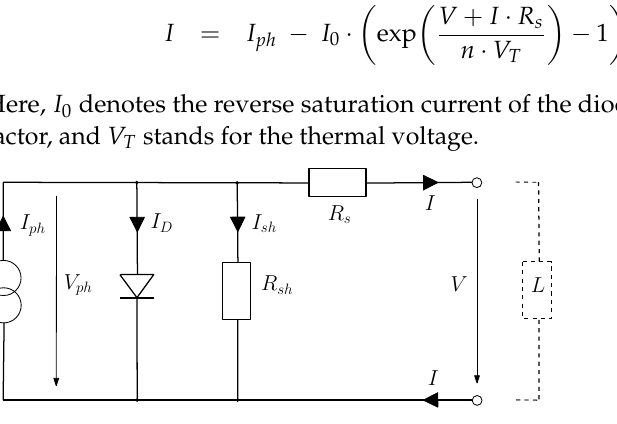
Figure 1. The single-diode model of a solar cell. I ph denotes the photogenetic current provided by the solar generator. One part of it, I D , passes through the diode in a forward direction. Another part, I sh , runs through shunt resistor R sh ; it models losses via leakage in the cell. The remaining current I passes through series resistor R s , which represents losses caused by imperfect contacts. The values of I , voltage V and generator voltage V ph depend on the load L at the cell’s